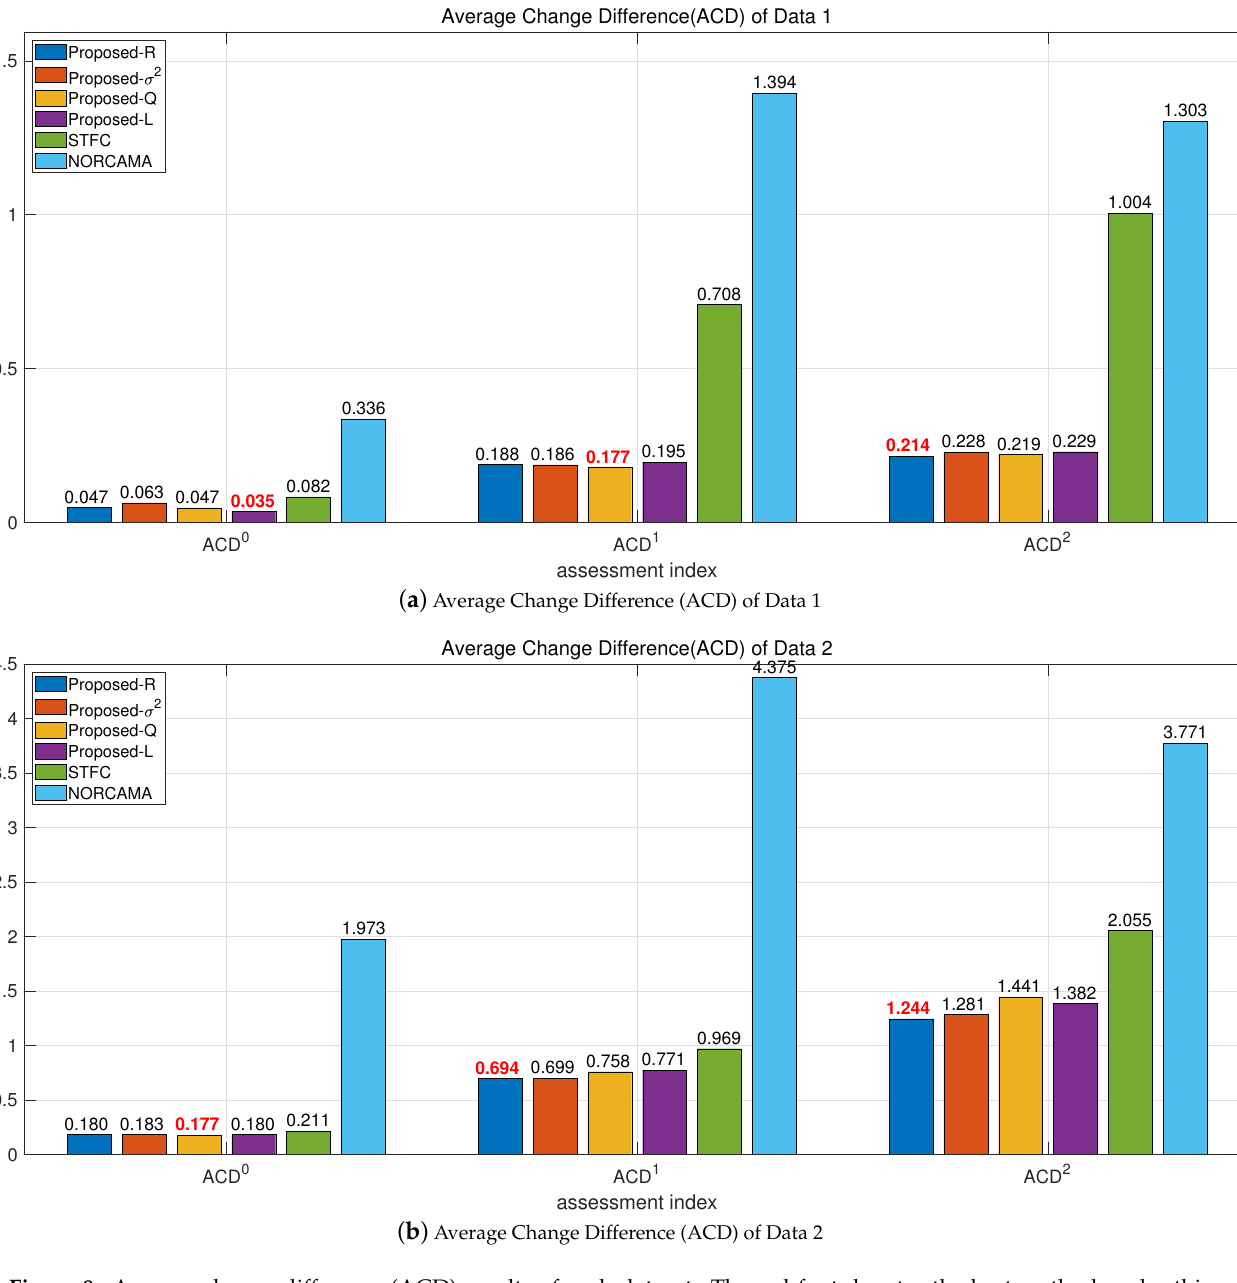
Figure 8. Average change difference (ACD) results of each dataset. The red font denotes the best method under this assessment